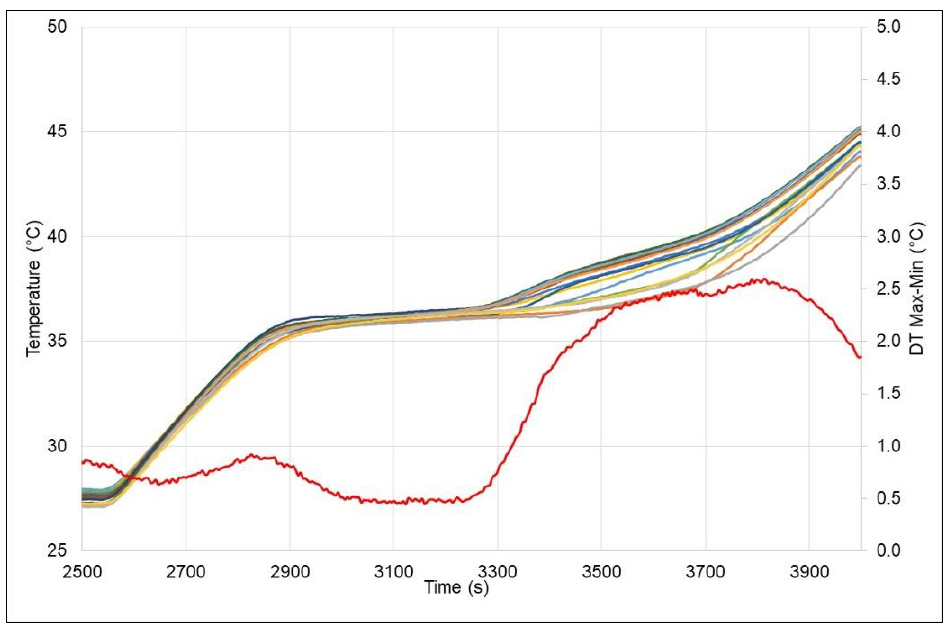
Figure 15. Wall temperature of the cells during an experimental run with a thermal dissipation of P = 2.2 W per cell.